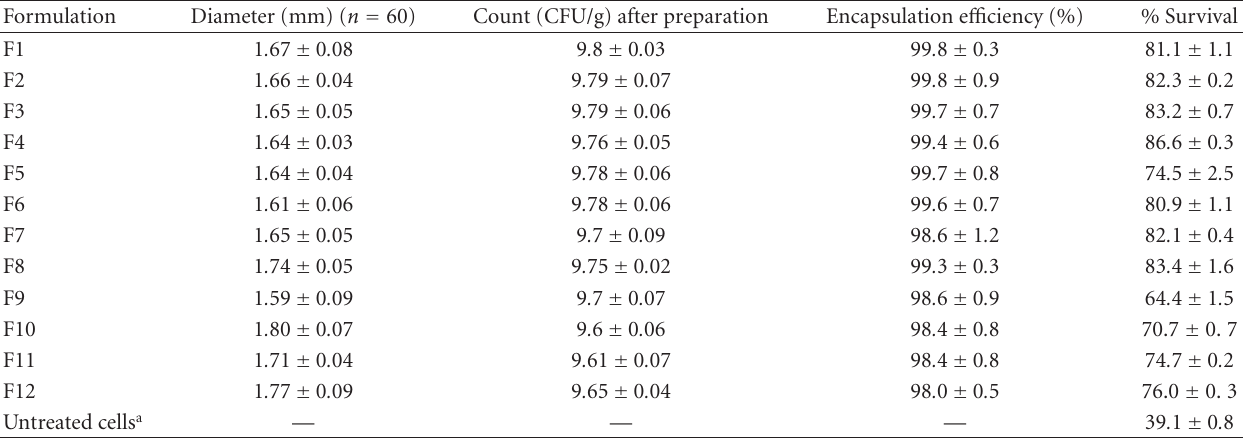
Table 2: Size, encapsulation e ffi ciency, and % survival in acid condition of prepared formulations.